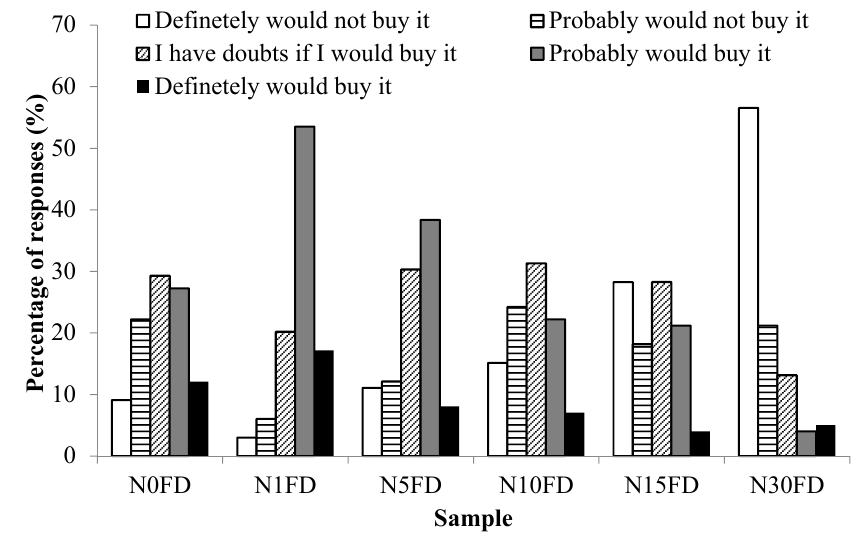
Figure 1. Purchase Intention for non-supplemented apple nectar (N0FD) or supplemented with 1 g/L (N1FD), 5 g/L (N5FD), 10 g/L (N10FD), 15 g/L (N15FD) or 30 g/L (N30FD) of freeze-dried araçá-boi.